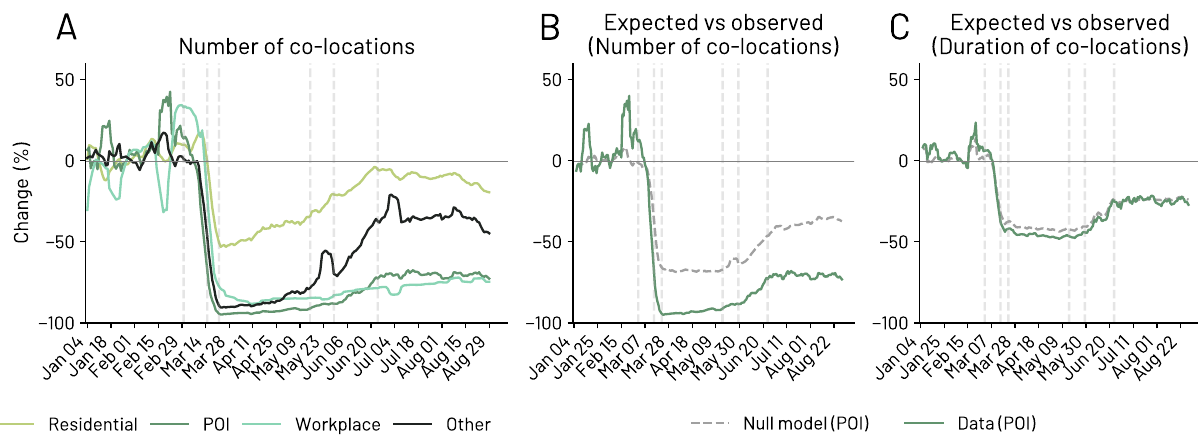
Figure 5. Co-location events. ( A ) Percentage change of co-location events from the baseline (until 29 February 2020) in New York state. We measure the change in co-location events for Residential areas (only one of the two individuals is in proximity of their residential area), POI (both individuals are at the same POI), Workplace (both individuals have the same work location) and Other co-location events. ( B , C ) We compare the difference between the expected and observed number and duration of co-location events. During the pandemic, individuals tend to have fewer and shorter co-locations than